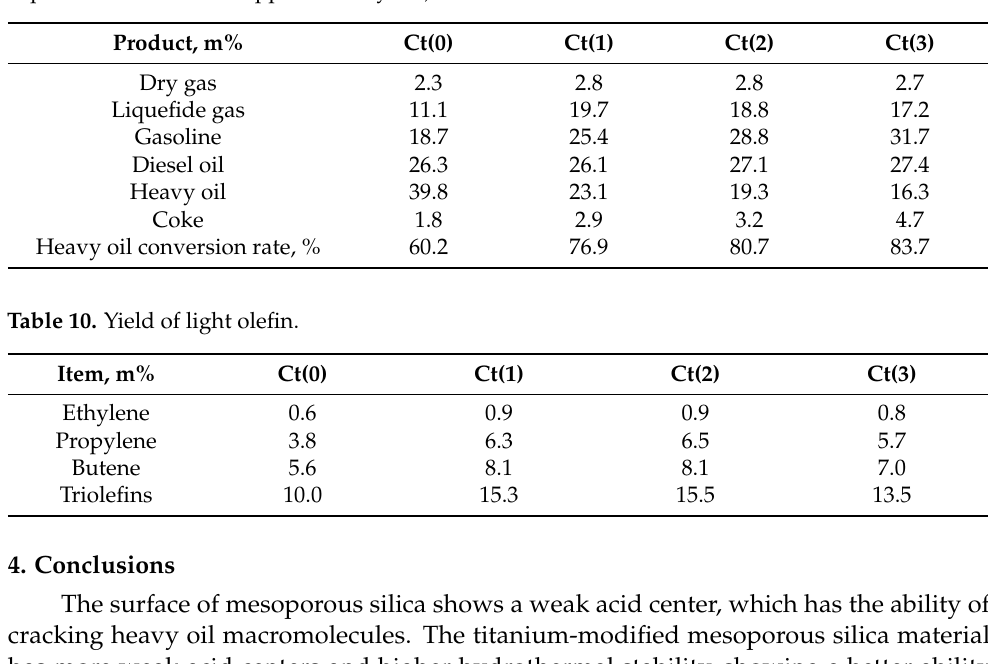
Table 9. Conversion and product distribution of formed catalyst in heavy oil catalytic cracking (the averaged conversion and product distribution of three measurements were recorded, and the experimental error was approximately 3%).